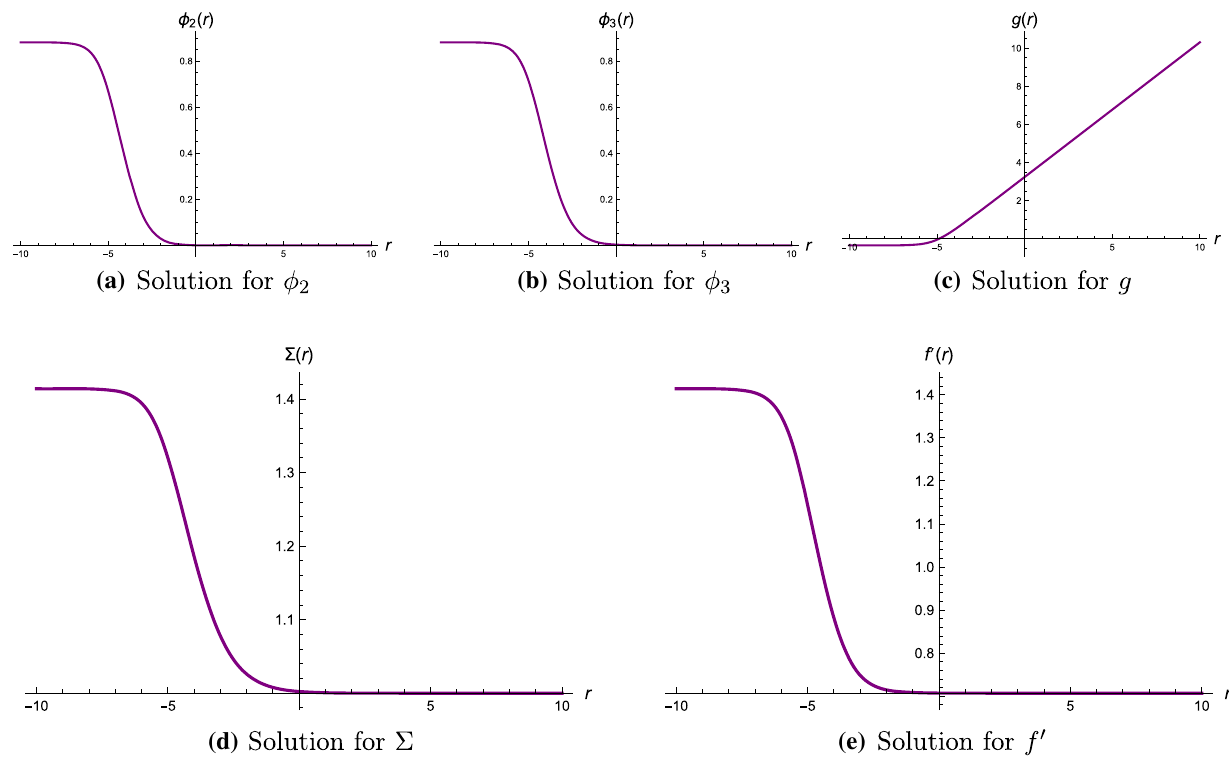
Fig. 5 An RG flow from AdS 5 critical point with U ( 1 ) × SU ( 2 ) × SU ( 2 ) symmetry to AdS 3 × H 2 critical point III for g 1 = 1 and g 3 = 2 g 1 Table 3 Scalar masses at the N = 4 supersymmetric AdS 5 critical point with U ( 1 ) × SO ( 3 ) symmetry and the corresponding dimensions of the dual operators for the non-compact U ( 1 ) × SO ( 3 , 1 ) gauge group